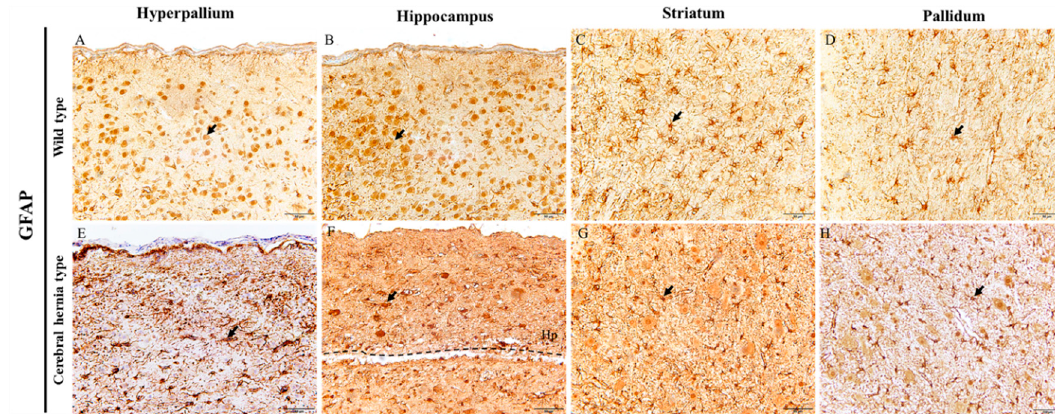
Figure 6. Immunohistochemistry of GFAP indicates abnormal astrocytes in telencephalon of chickens with cerebral hernia. ( A – D ) The astrocytes detected with GFAP antibodies are present with clear protuberances and even distribution in the H, Hp, St, and P regions of wild type chicken telencephalon, respectively. ( E – H ) The GFAP positive signals are localized in astrocytes in the H, Hp, St, and P regions of telencephalon in cerebral hernia type chickens, respectively. ( E ) The astrocytes are aggregated at some point in the H region. ( F ) The astrocytes are irregularly distributed in the Hp region. ( G ) Compared to wild type chickens, the astrocytes had intensely stained signals in the St region. ( H ) The protuberances of astrocytes are shrunken and blurred in the P region. Scale bars = 50 µ m (all panels).